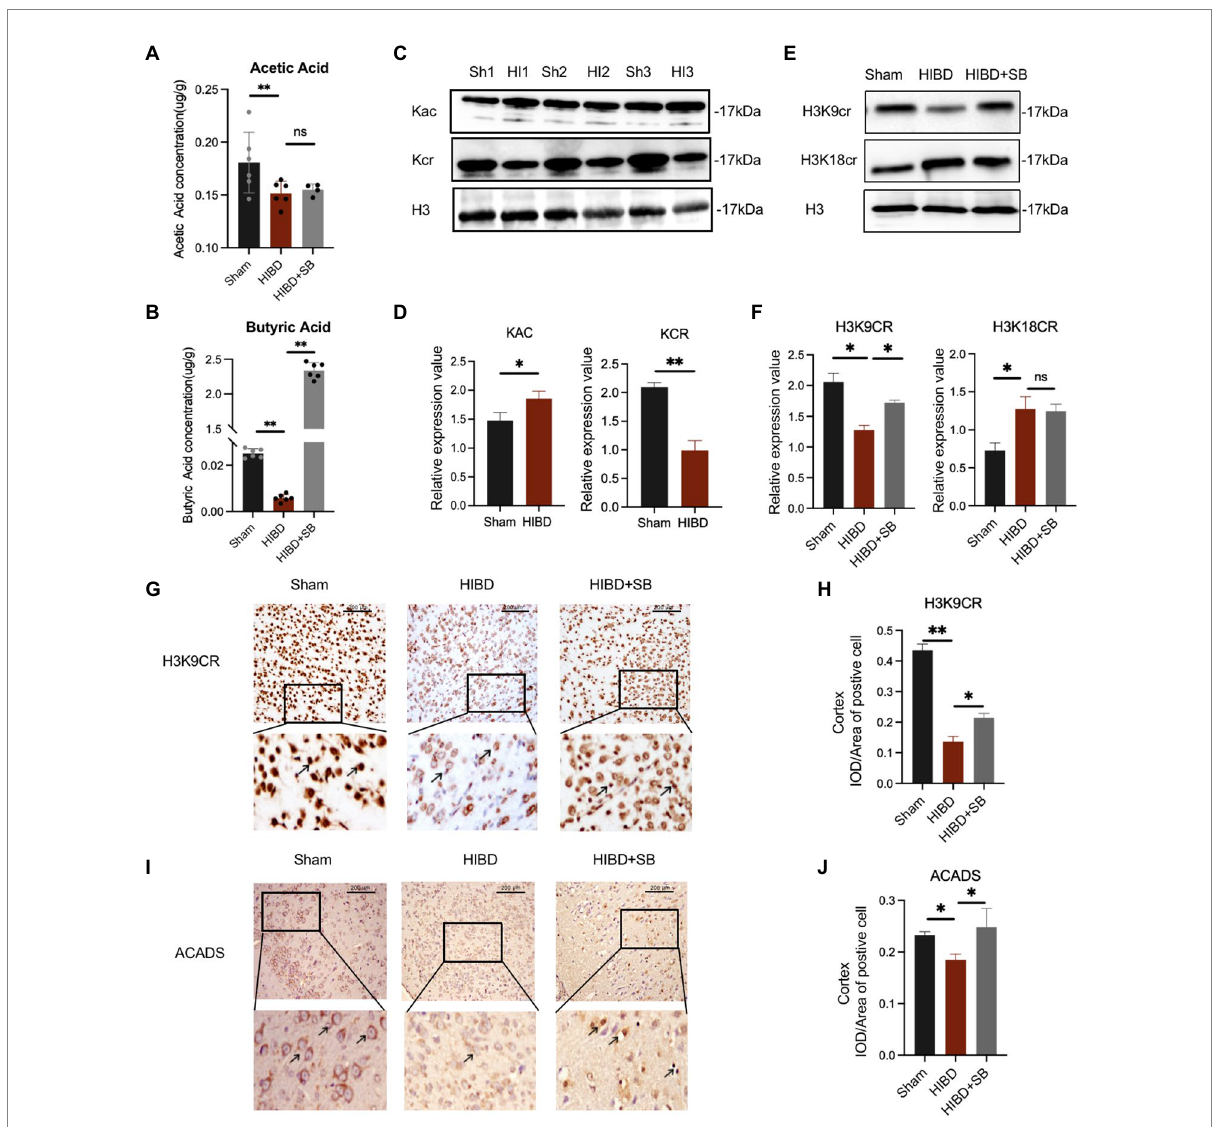
FIGURE 6 ( A,B ) The concentration of acetic acid and butyric acid in the brain tissue ( μ g/g). Data are shown as mean ± SD, n = 6, error bars represent SD, Statistical significance was considered at ns: not significant, * p < 0.05, ** p < 0.01 for one-way ANOVA analysis. ( C ) Changes of acetylation and crotonylation in brain tissue after HI which was analyzed by Western blot with anti-Kac and anti-Kcr antibodies. ( D ) Relative abundance analysis of ( C ), n = 3, error bars represent SD, * p < 0.05, ** p < 0.01 for one-way ANOVA analysis. ( E ) Brain H3K9cr and H3K18cr expression was analyzed by Western blot of Sham, HIBD and HIBD + SB group. ( F ) Relative abundance analysis of ( E ), n = 3, error bars represent SD, ns: not significant, * p < 0.05, ** p < 0.01 for one-way ANOVA analysis, error bars are standard deviation. ( G ) Immunohistochemical of the H3K9cr expression level of cerebral cortex in three groups. ( H ) Relative abundance analysis of ( G ), n = 3, error bars represent SD, * p < 0.05, ** p < 0.01 for one-way ANOVA analysis, error bars are standard deviation. ( I ) Immunohistochemical of the ACADS expression level of the cerebral cortex in three groups. ( J ) Relative abundance analysis of ( I ), n = 3, error bars represent SD, ns: not significant, * p < 0.05, for one-way ANOVA analysis, error bars are standard